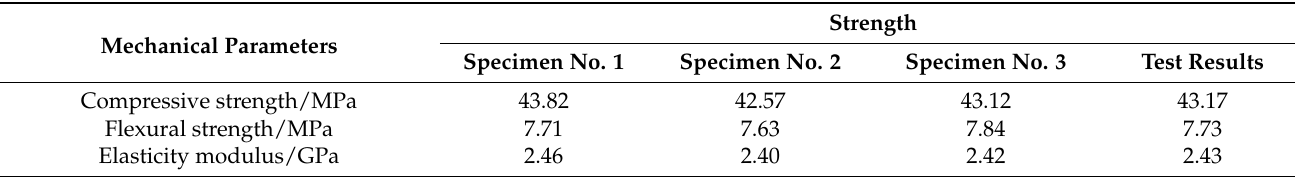
Table 7. The mechanical parameters of ceramsite concrete at 28 d.